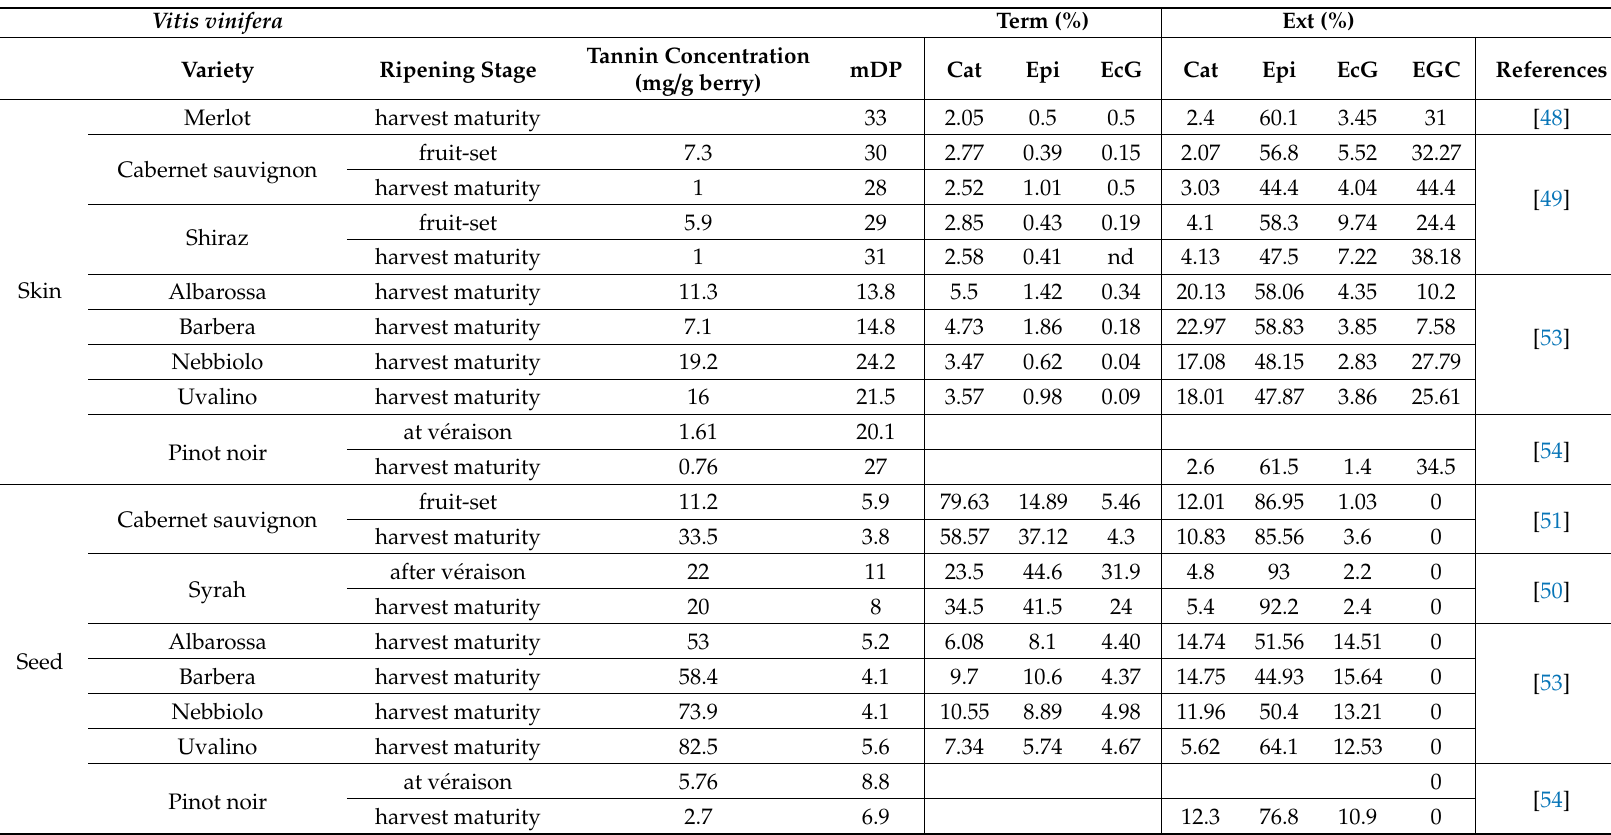
Table 1. Tannin concentration and composition in Vitis vinifera grape skins and seeds, including mean degree of polymerization (mDP), terminal constitutive units (Term) and extension (Ext) units. Cat, catechin; Epi, epicatechin; EcG, Epicatechin gallate; EGC, Epigallocatechin; nd, not